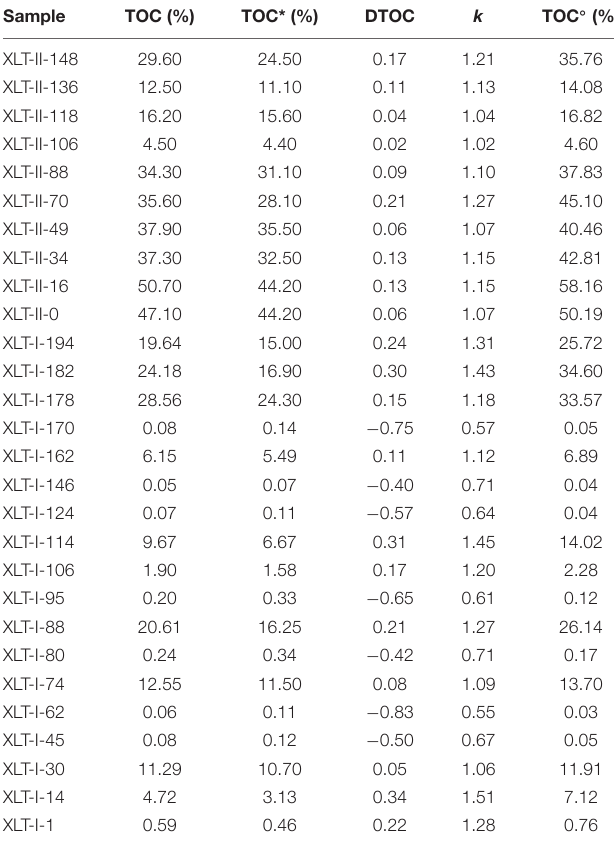
TABLE 3 | Total organic carbon (TOC) restoration parameters of Xiaolongtan Basin sediments.